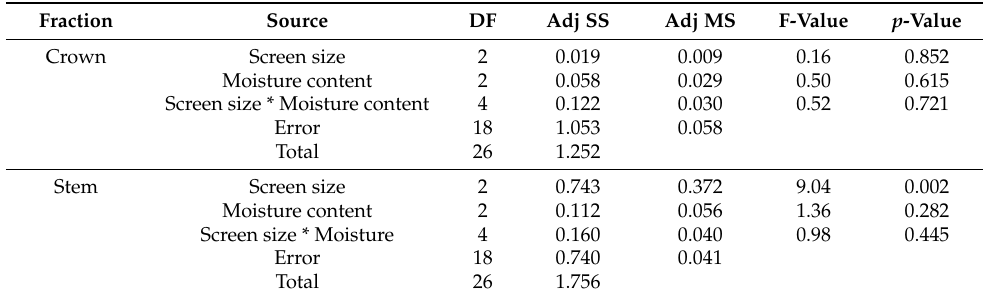
Table 5. ANOVA effects of screen size and moisture content on relaxation ratio of crown and stem fractions of the briquette ( p < 0.05).